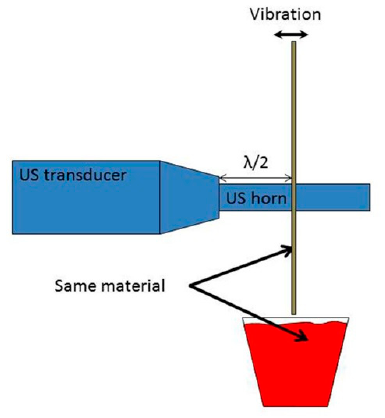
Figure 1. A schematic of the experiment.